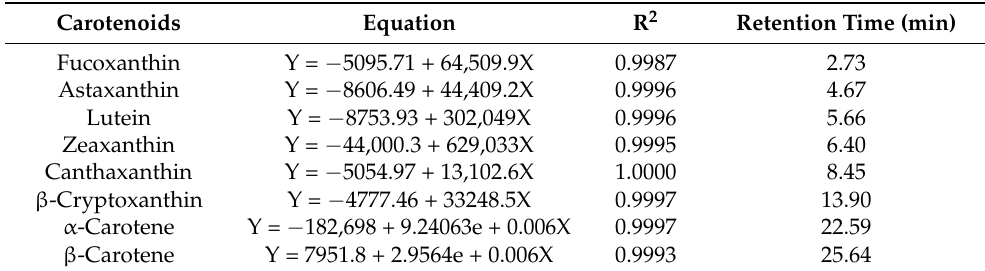
Table 1. Calibration curve equations, R2, and retention times of each